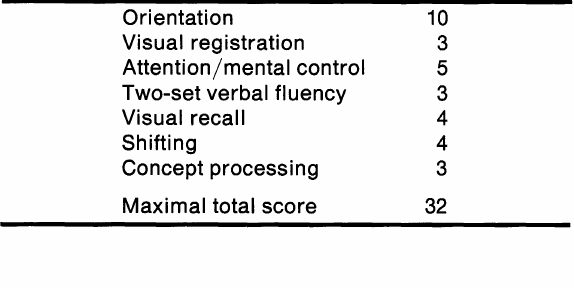
TABLE II. Mini-Mental Parkinson subsections and scores